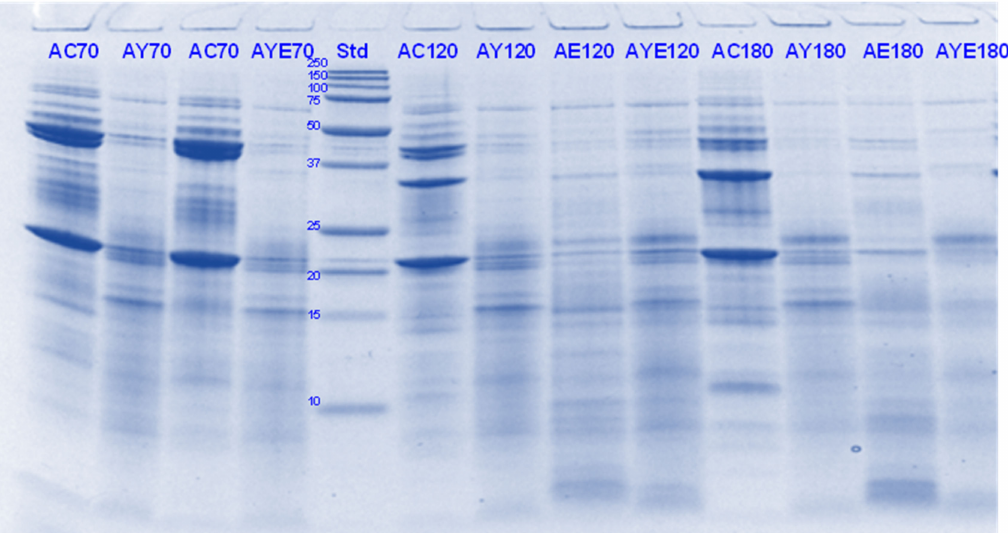
Figure 14. Tricine SDS-PAGE electrophoretogram of almond (A) digests after 70, 120 and 180 min of simulated oral-gastric-small intestinal digestion in the presence or absence of SunGold (Y) kiwifruit extract. AC, almond (A) control without any digestive enzymes; AY, with added gold kiwifruit extract but no digestive enzymes; AE, with digestive enzymes but no added kiwifruit extract; AYE, with both digestive enzymes and gold kiwifruit extract. Numbers 70, 120 and 180 are the total digestion times in oral-gastro-small intestinal digestion (including 60 min of gastric digestion). Bands (1–10) in the molecular weight standard lane correspond to molecular weights 250, 150, 100, 75, 50, 37, 25, 20, 15 and 10